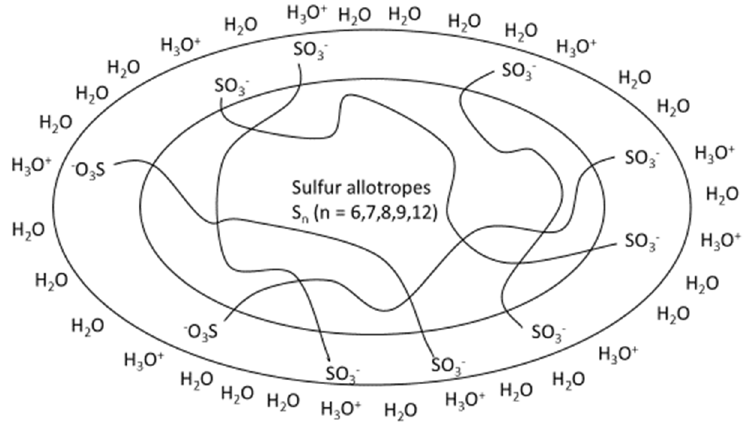
Figure 1. Schematic model for the composition of the particles in hydrophilic sulfur sols consisting of long-chain polythionates S n (SO 3− ) 2 and sulfur homocycles S n (according to [30,35]).